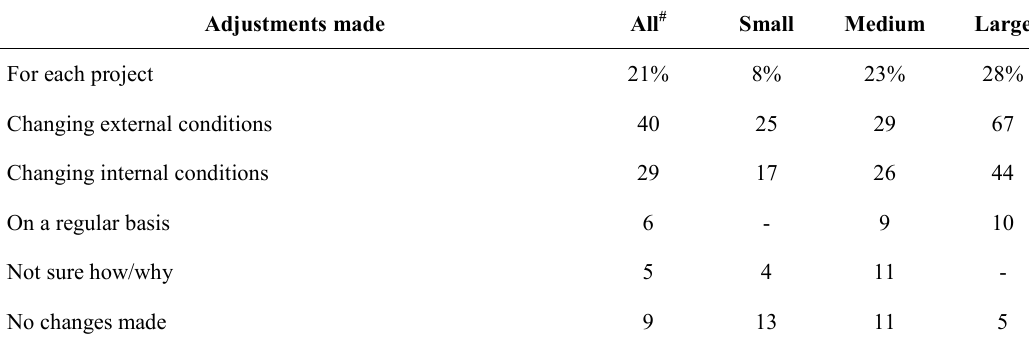
Table 5. Adjustments to the hurdle/discount rate used (all firms) Adjustments made All # For each project Changing external conditions